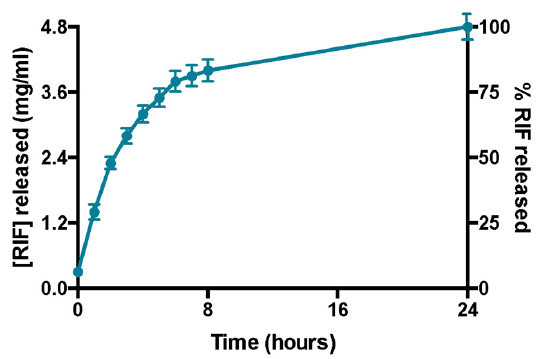
Figure 4. Profile of release of rifampicin over 24 h. Data were obtained as the mean of three independent experiments.